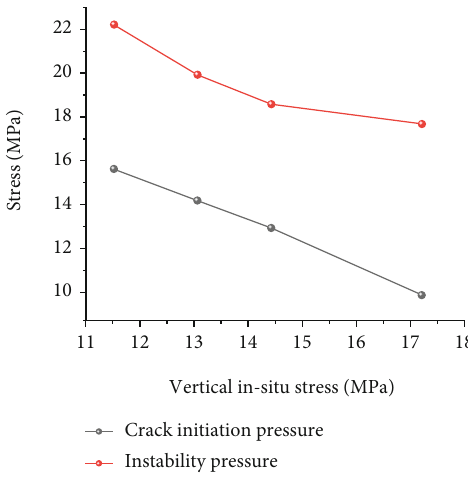
Figure 8: E ff ect of vertical stress on hydraulic